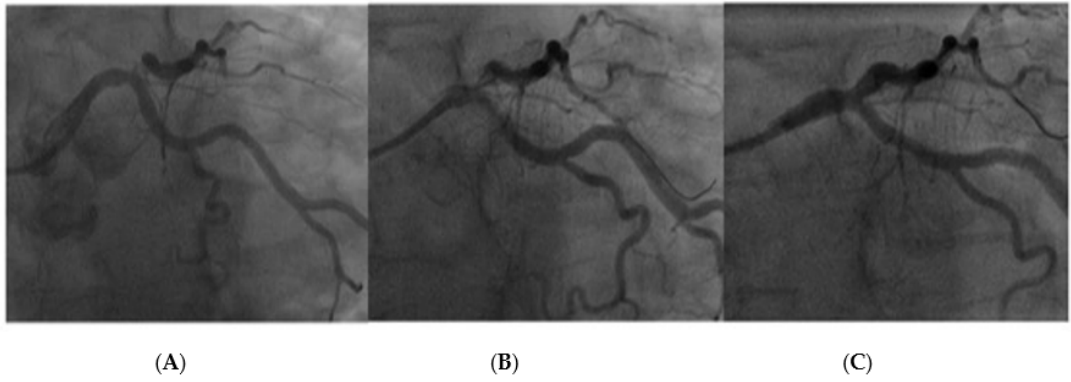
Figure 10. LMS lesion requiring bail-out stent due to dissection with ongoing chest pain after DCB and contrast hang-up. Image ( A ): LMS pre-treatment, Image ( B ): Dissection after delivery of DCB with persistent contrast hang-up and increasing lumen compromise, Image ( C ): Post-DES final result.